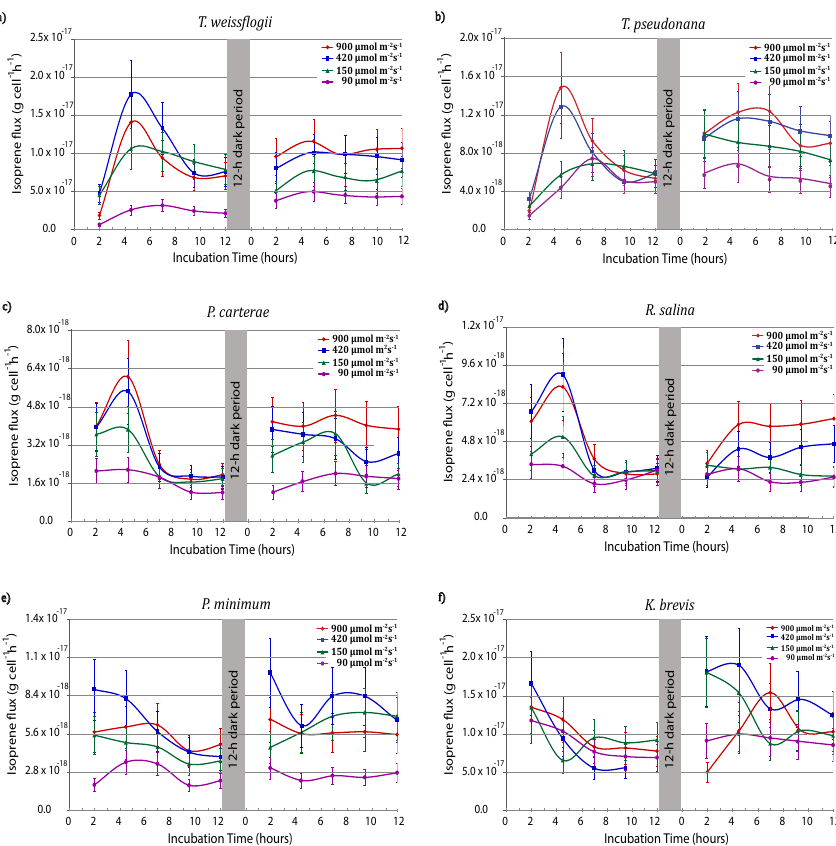
Figure 2. Light stress production rates for isoprene (gcell − 1 h − 1 ) as a function of time during the first (0 to 12h) and second (12 to 24h) light cycles. Note that there was a 12h dark period between the two five-point sample sets and that the first samples in each set were collected 2h after lights on. Error bars denote the RSD Total value listed in Table